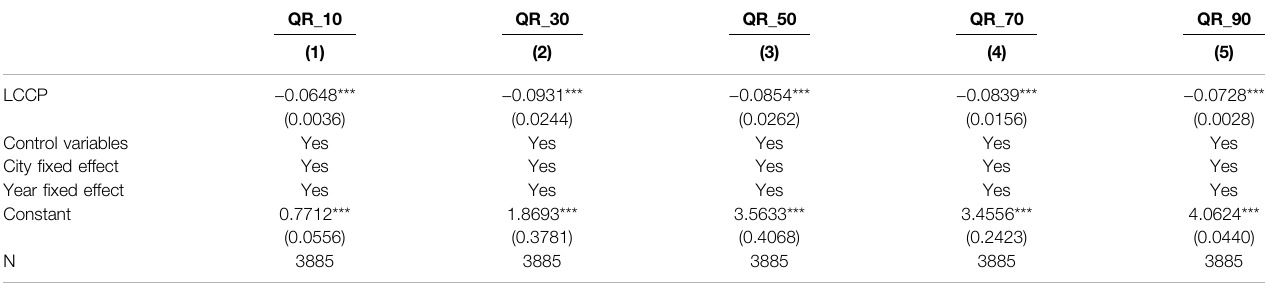
TABLE 10 | Quantile